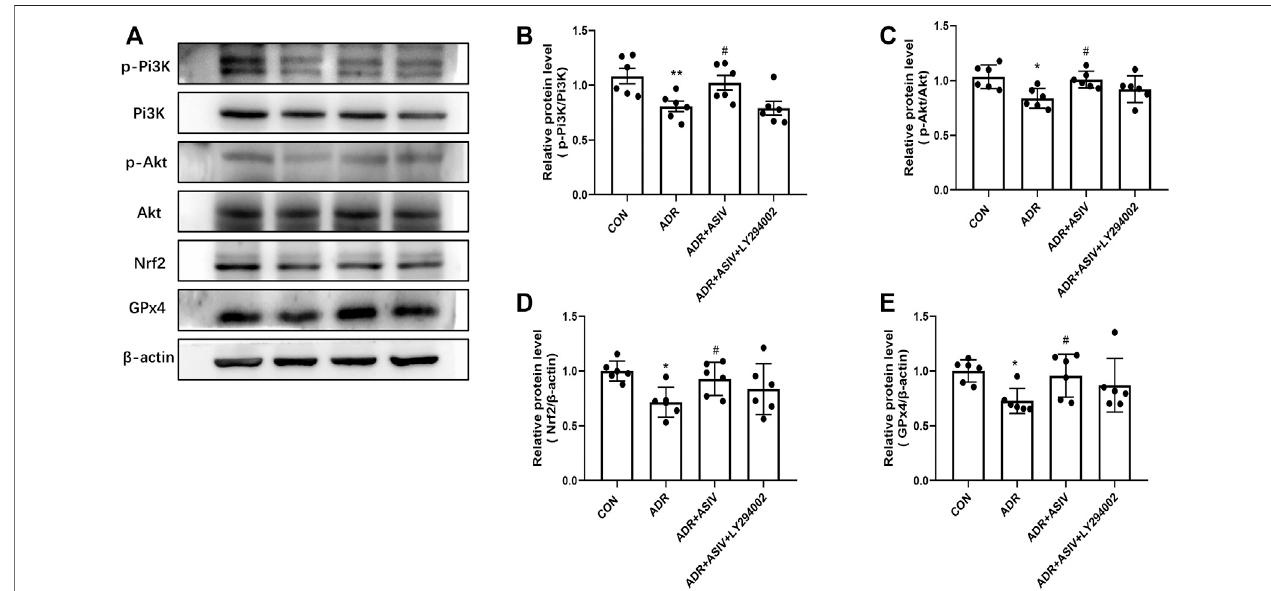
FIGURE 7 | ASIV alleviated ADR-induced ferroptosis was related to the inhibition of the Pi3K/Akt/Nrf2 pathway in vitro . (A) Representative image for the levels of p-Pi3K, p-Akt, Nrf2, and GPx4detected byWesternblotting. Semiquantitative measurementsof p-Pi3K (B) , p-Akt (C) , Nrf2 (D) , and GPx4 (E) . * p < 0.05, ** p < 0.01 vs. CON group. Data were expressed as mean ± SD, n = 6. # p < 0.05, ## p < 0.01 vs. ADR